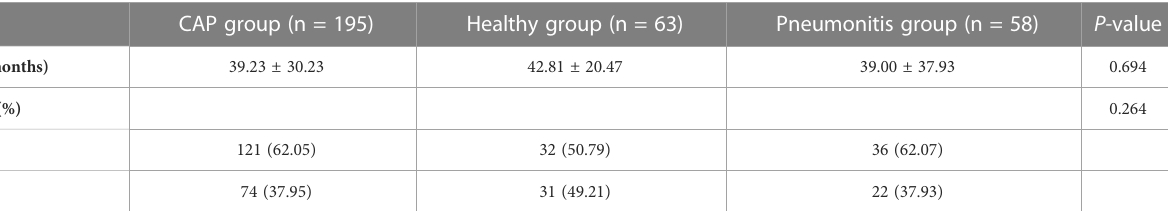
TABLE 1 General information of CAP group and control groups.